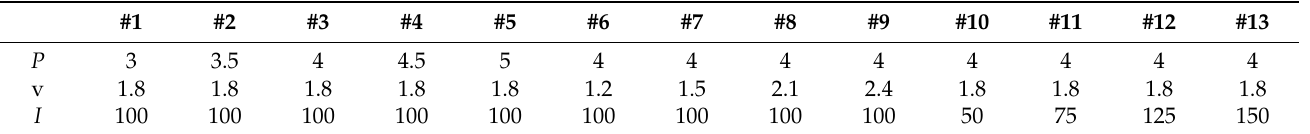
Table 3. Welding parameters for laser-arc hybrid welding, where P is laser power, v is welding speed and I is welding current.